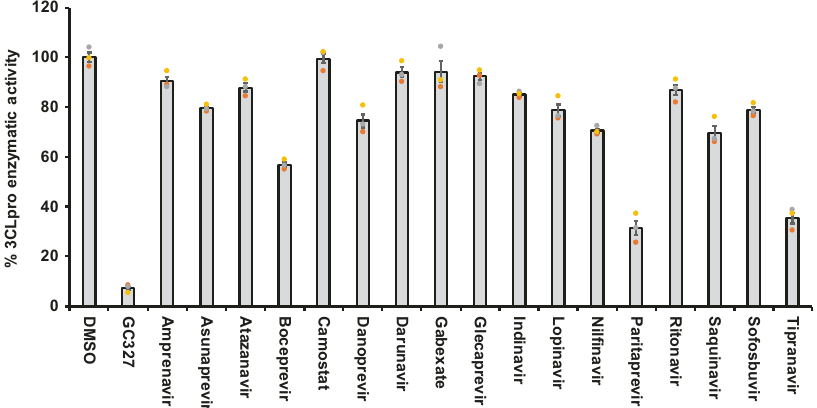
Fig. 2 Protease inhibitors boceprevir, paritapravir, and tipranavir exhibited partial inhibitory activity against SARS-CoV-2 3CLpro enzyme. The selected FDA approved viral-protease inhibitors were screened for their inhibitory activity against SARS-CoV-2 3CLpro enzyme as described under Methods section. The fl uorescence units were converted to percent enzymatic activity considering DMSO treated control as 100% activity. Blank values were subtracted from all the readings before calculating the percent activity. Representative of three individual experiments with triplicate values were presented graphically ( n = 3). P value < 0.001 considered as statistically signi fi cant. One-way ANOVA with Dunnett ’ s Multiple Comparison post-hoc test was used to calculate the statistical signi fi cance.